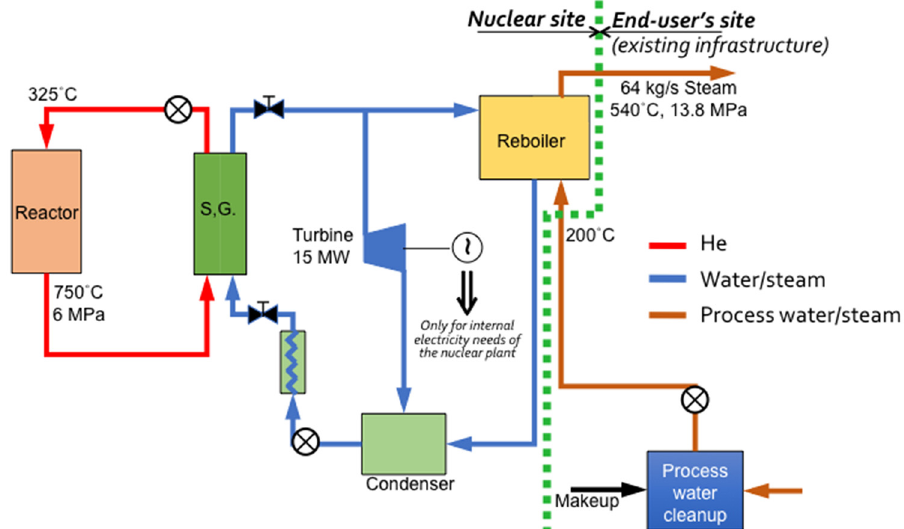
Fig. 6. General con fi guration of the nuclear plant with 185 MW th